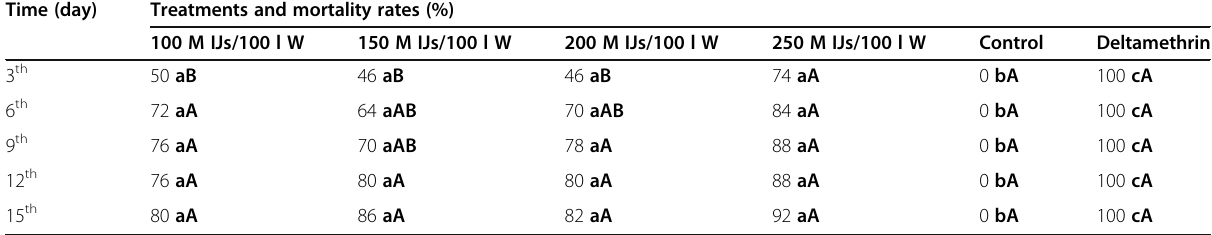
Table 1 Time-dependent mortality rates (%) of different concentrations of Steinernema feltiae on Mecorhis ungarica Time (day) Treatments and mortality rates (%)